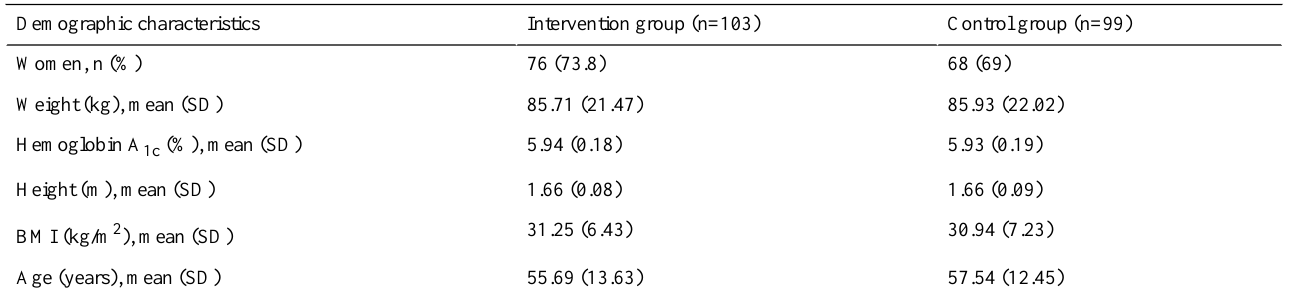
Table 1. Baseline characteristics of the study